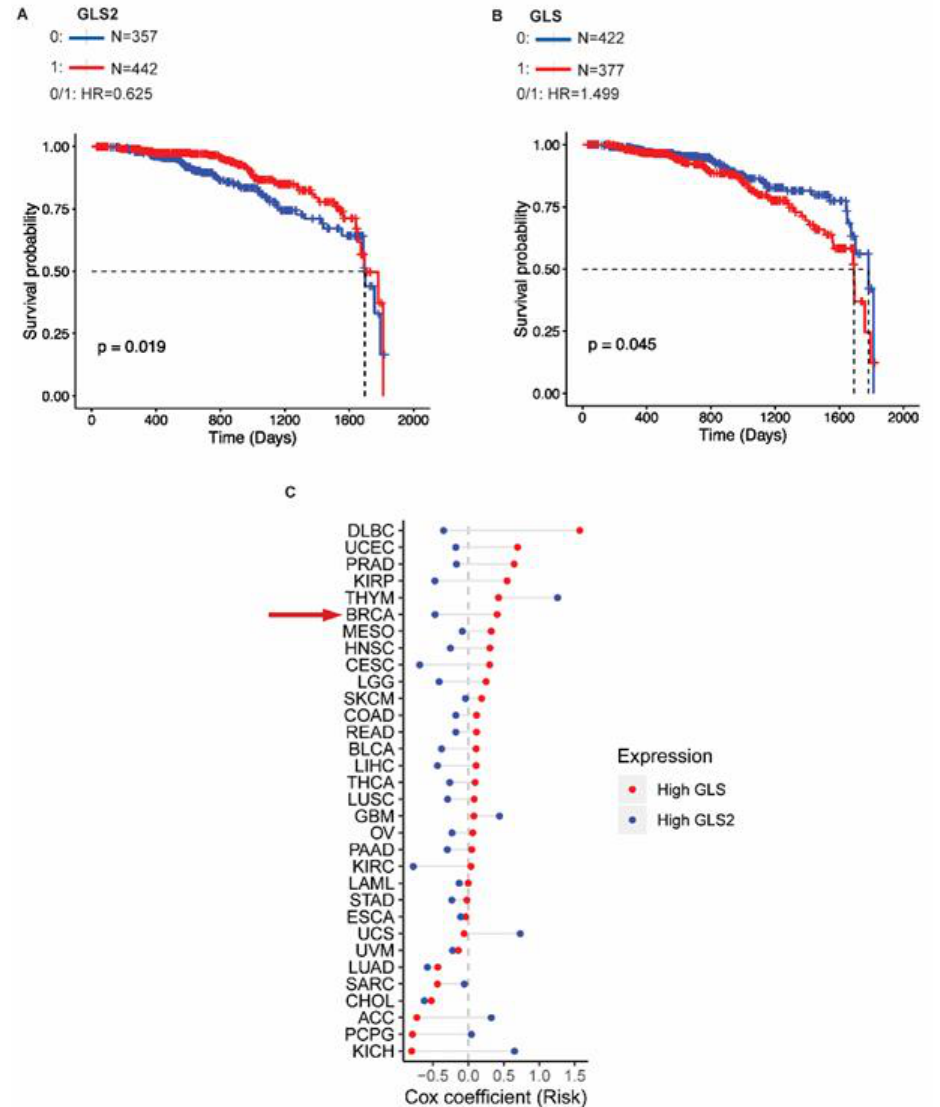
Figure 5. GLS2 expression is associated with better overall survival in breast cancer patients. ( A ) Survival probability versus time for breast cancer patients that express GLS2 (red lines) and those that do not (blue lines). ( B ) Survival probability versus time for breast cancer patients that express GLS (red lines) and those that do not (blue lines). ( C ) Cox risk coefficients for in cancer patients with various types of tumors, including those of the breast (BRCA, indicated with red arrow) associated with expression of GLS (red circle) and GLS2 (blue circle).